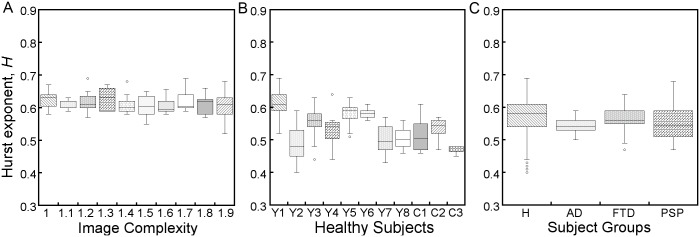
Box plots showing comparison of the Hurst exponent, H, across (A) image spatial complexity with the number of images analyzed n = 19, 5, 7, 6, 7, 8, 8, 6, 7 and 7 respectively, (B) individuals within the participant group H with n = 83, 21, 72, 8, 19, 9, 10, 6, 10, 18 and 3 respectively and (C) participant groups with n = 259, 24, 14, and 43 respectively.